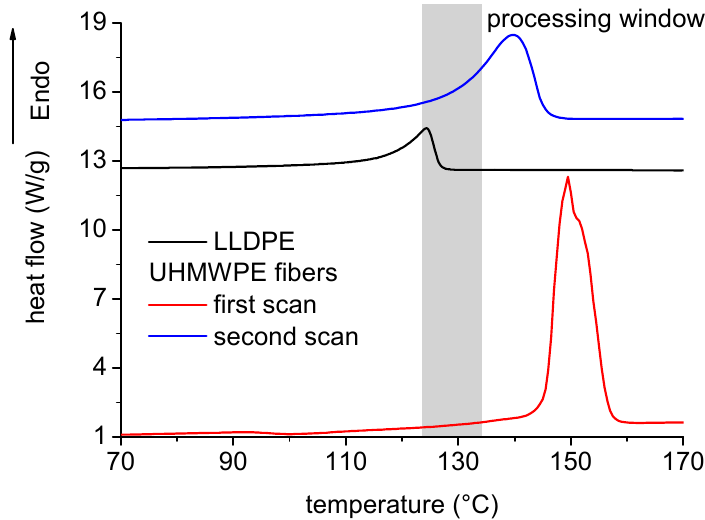
Figure 4. DSC curves on ultra-high molecular weight polyethylene (UHMWPE) fibers and linear low-density polyethylene (LLDPE) matrix.